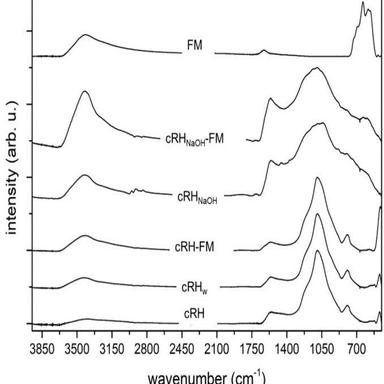
FTIR spectra of the materials acquired on KBr pellets in the 500–3900 cm− 1 range.